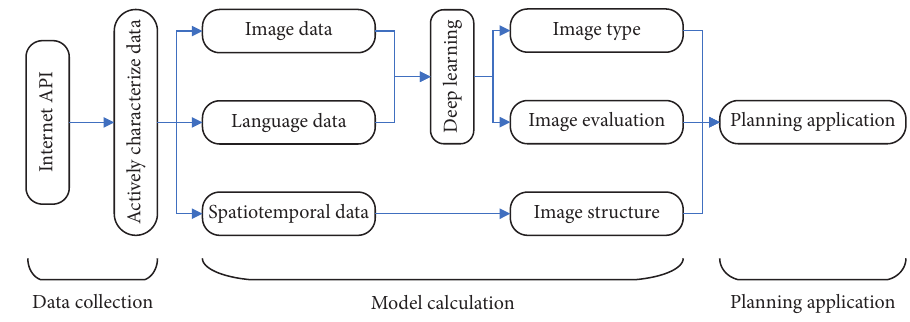
Figure 2: Framework of city image cognitive model.